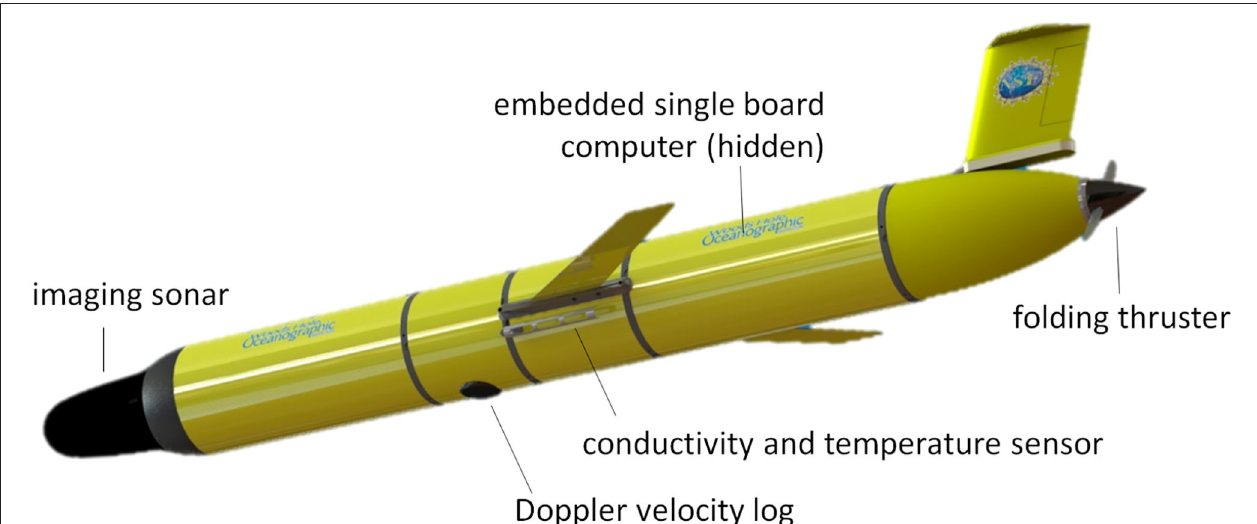
FIGURE 2 | CAD rendering of the Polar Sentinel glider, showing relative locations of the mechanically scanned imaging sonar, Doppler velocity log, conductivity and temperature sensor, embedded single board computer, and folding thruster.